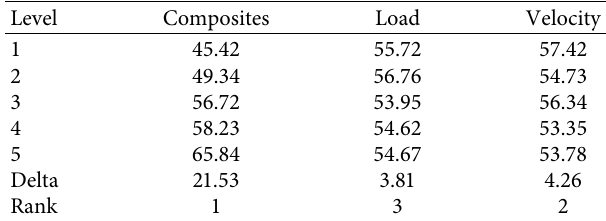
Table 5: S / N ratio’s response.